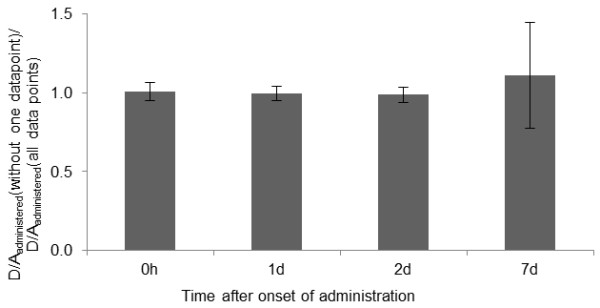
Mean absorbed dose per unit administered activity, excluding one of the data points (CVreduced datamethod). Mean absorbed dose per unit administered activity to the kidney determined excluding one of the data points (1 h, or 1, 2, or 7 days after administration) divided by the mean absorbed dose per unit administered activity including all data points. Error bars indicate ± 1 SD. Note that the value, when excluding the day 7, data point is underestimated since values of infinity were excluded.